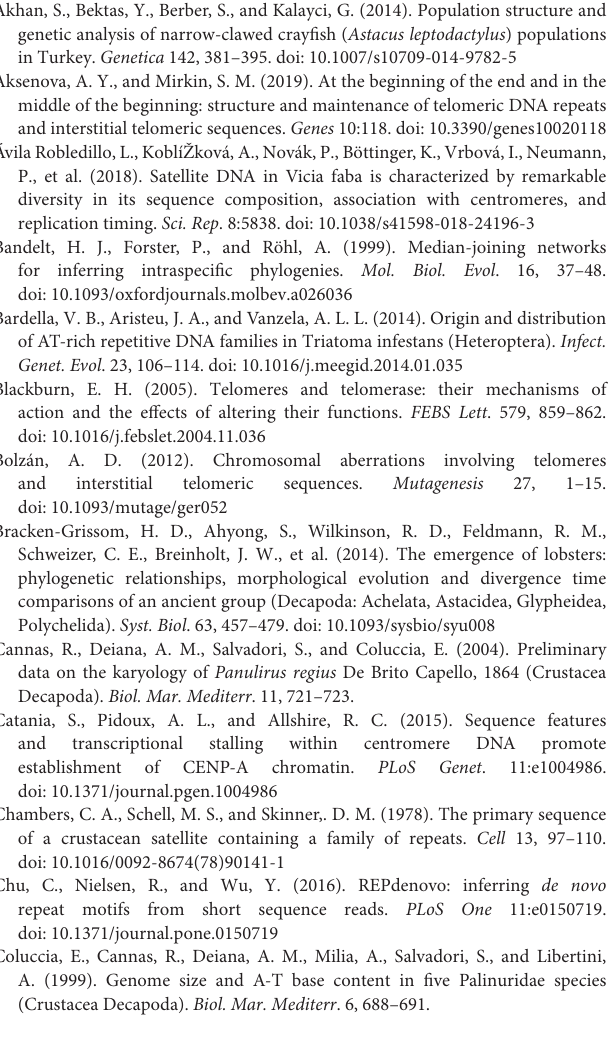
Supplementary Table 1 | COI gene sequences from P. leptodactylus used to construct a phylogenetic tree. Supplementary Table 2 | Pontastacus leptodactylus satellitome. Repeat unit lengths, G + C content (%), abundances (%), and consensus sequence. Supplementary Table 3 | Morphometric measurements of P. leptodacylus chromosomes ( n = x = 90). Supplementary Figure 1 | Consensus sequences of PlSAT1-21, PlSAT3-411, PlSAT6-70, PlSAT7-134, and PlSAT14-79 repeats in fasta format. Primer sequences for amplification of tandem repeat specific probes are underlined and bolded.